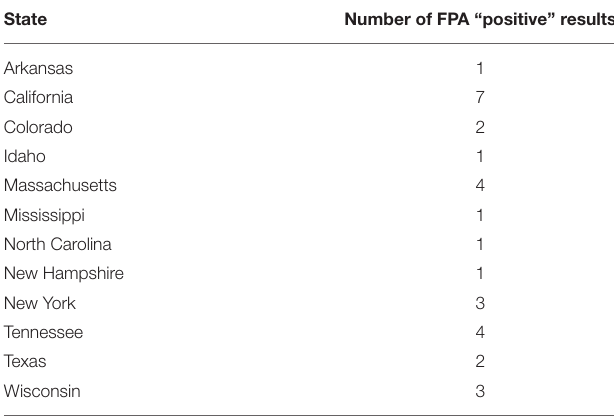
TABLE 7 | Geographic location of the 30 FPA test interpretation “positive”